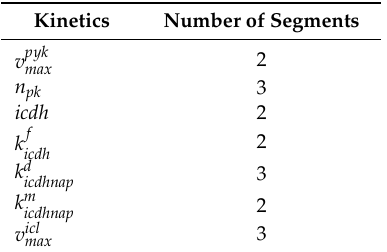
Table A4. STD and mean of the simulated results.